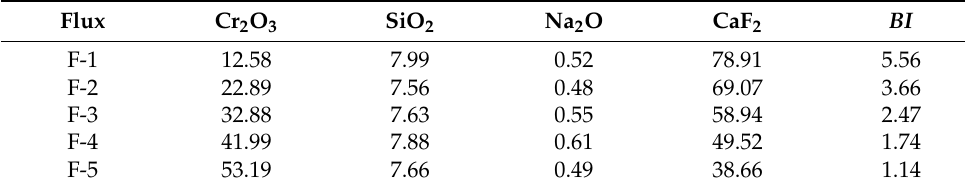
Table 2. Measured compositions of fluxes (wt.%).